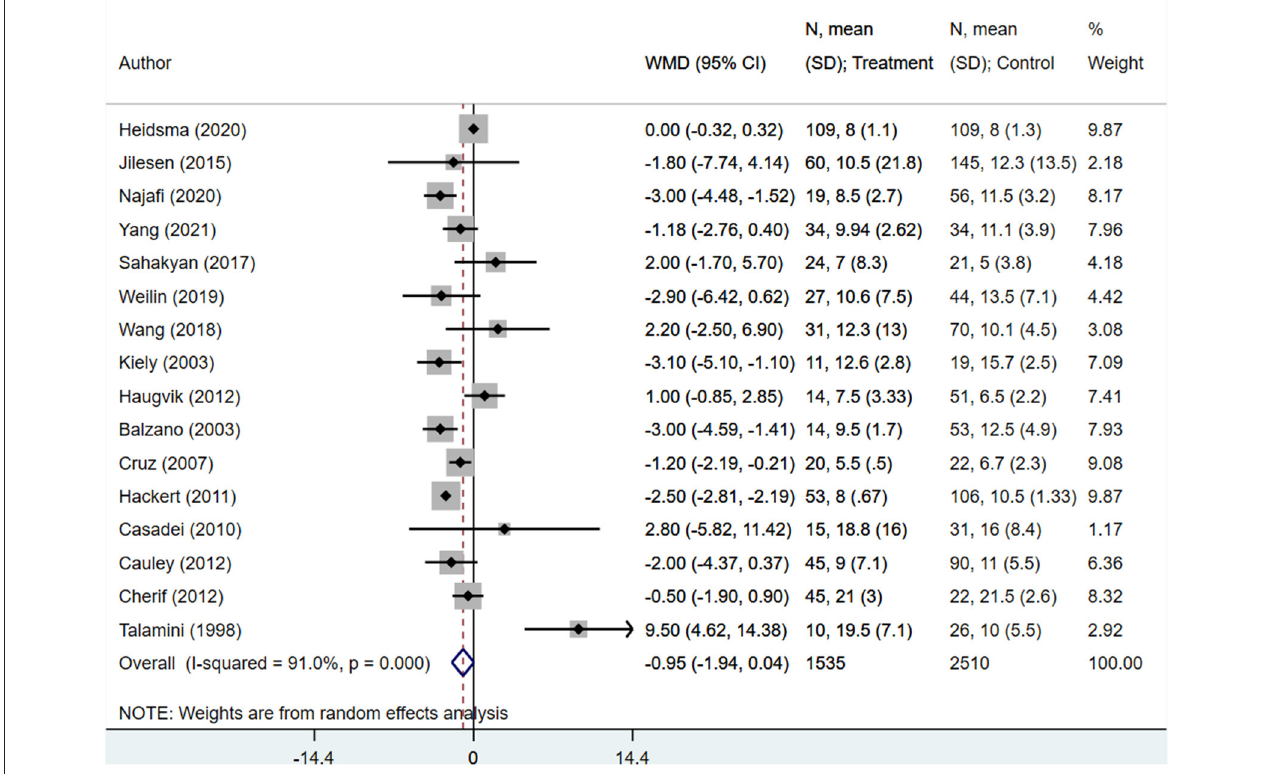
( Figure 5 ). However, the risks of endocrine (RR 0.32; 95%